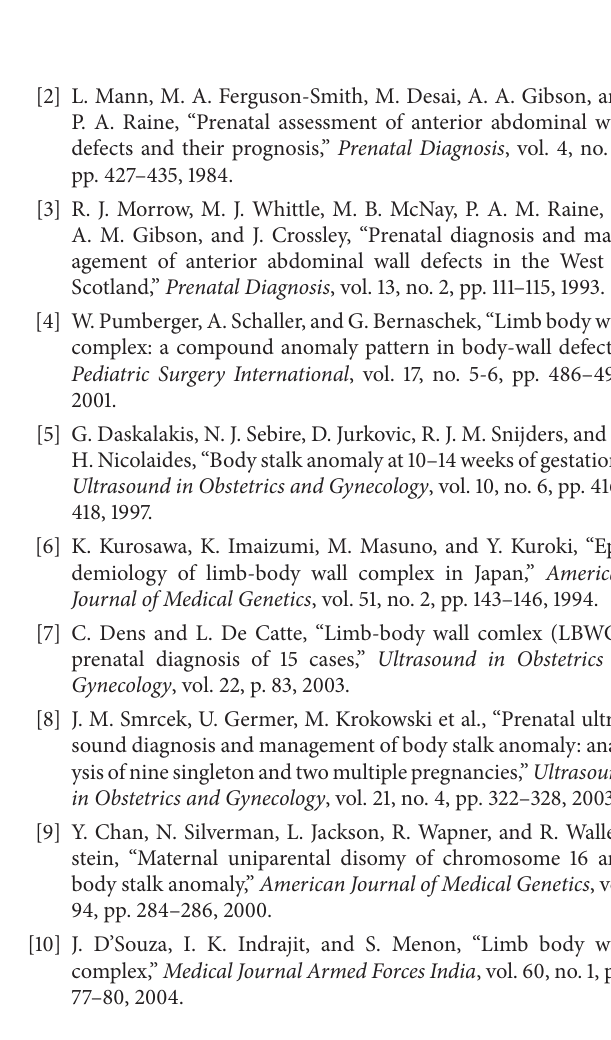
Figure 11: Pathways of body stalk anomaly/amniotic band syndrome arising from different primary events (modified model of Luebke et al.